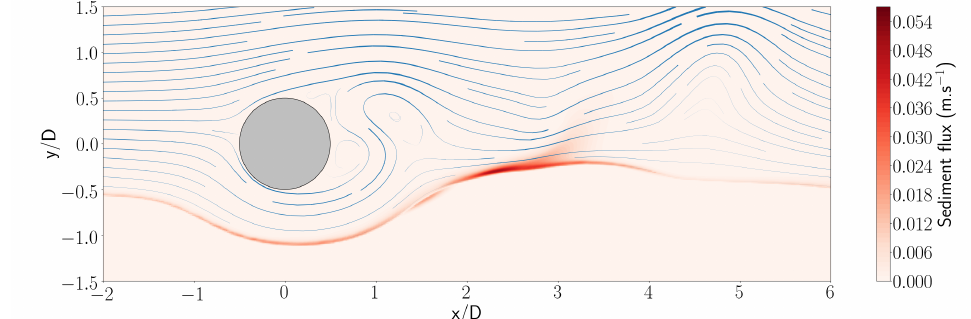
Figure 6. Streamlines and sediment volumetric flux at 25 s for the simulation using the k − ω /2006 turbulence model.